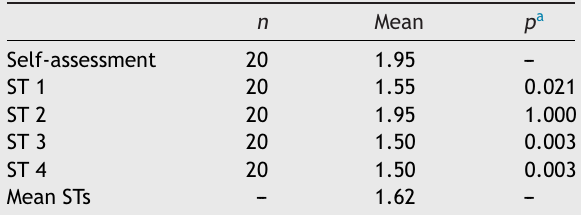
Table 4 Comparative statistical analysis between speech therapists and